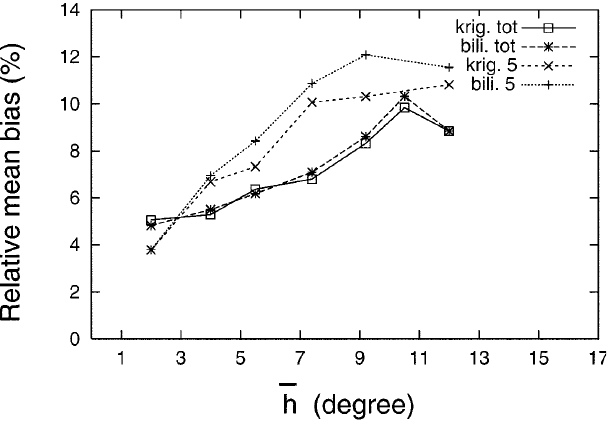
Fig. 5. Relative biases between SBUV data and those found by interpolation with kriging and by bilinear interpolation from Delaunay triangulation versus the mean separation distance h . Results are averaged over gaps of the 14 satellite tracks for the total ozone field and for layer 5 on October